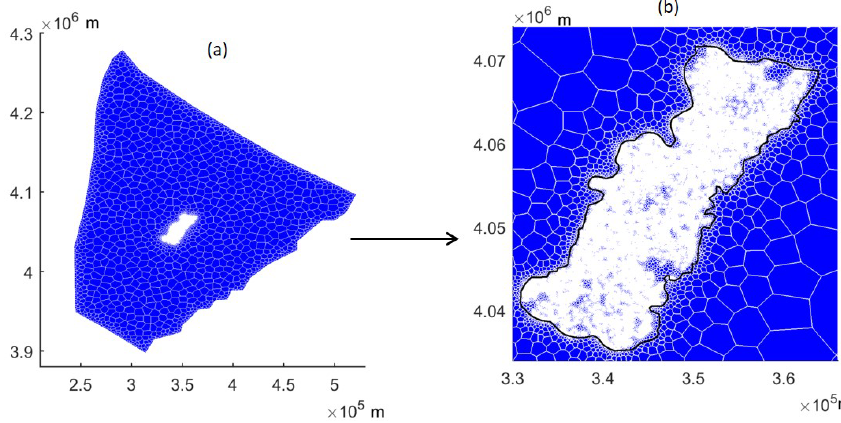
Figure 6. Discretization map of the large model.